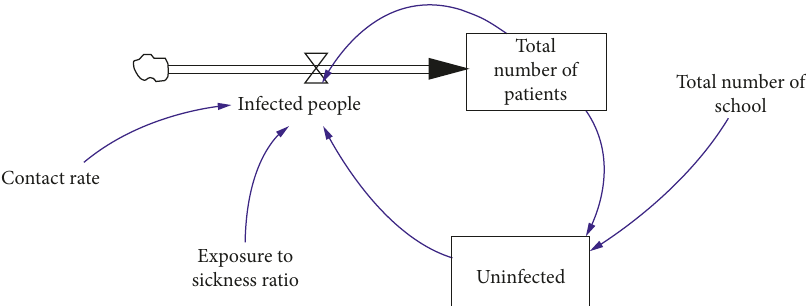
Figure 3: Logical framework diagram of an infection in the first stage.